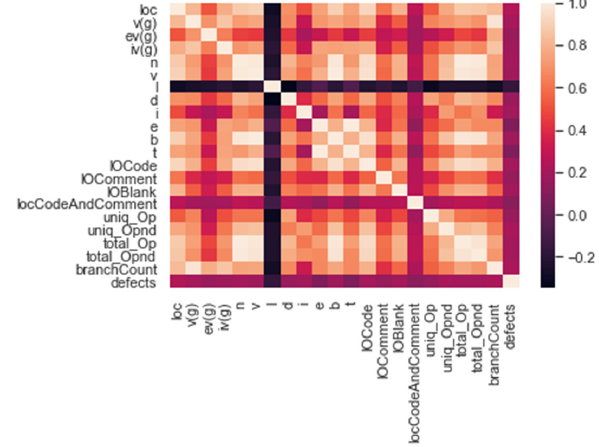
Figure 2. Co ‐ relation graph of the NASA dataset . Figure 2. Co-relation graph of the NASA